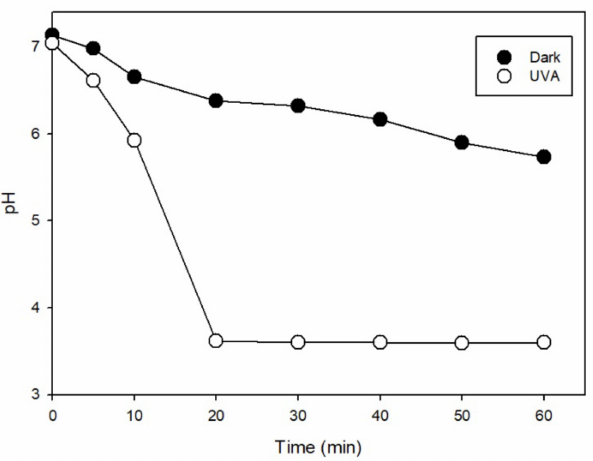
Figure 2. Change of pH during reaction in aerated solutions. Conditions: [PARA] 0 = 10 µ M, [Fe(III)] 0 = 0.1 mM, [S(IV)] 0 = 1.0 mM, pH init =